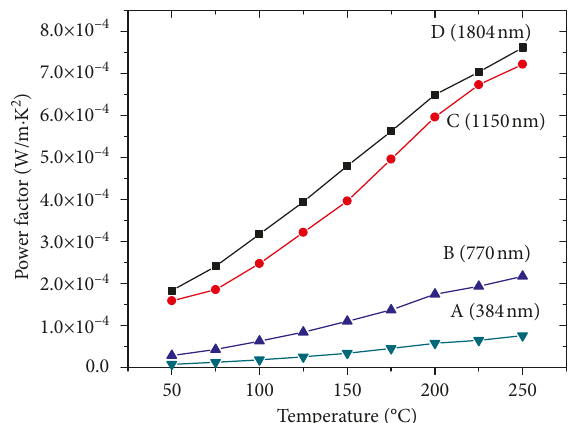
Figure 5: The variation of power factor as a function of tem- perature for Sb 2 Te 3 films with varying